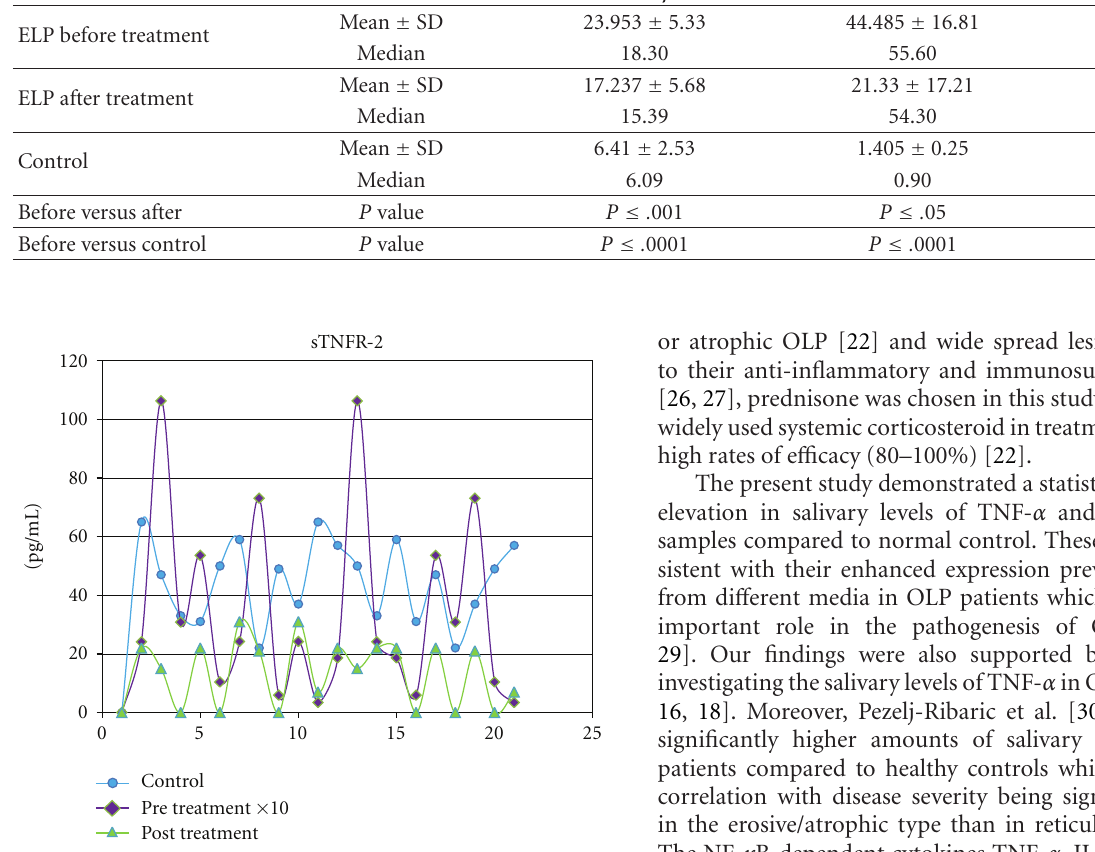
Figure 3: Salivary levels of sTNFR-2 measured in pg/mL from control subjects compared with levels in ELP patients before and after treatment with